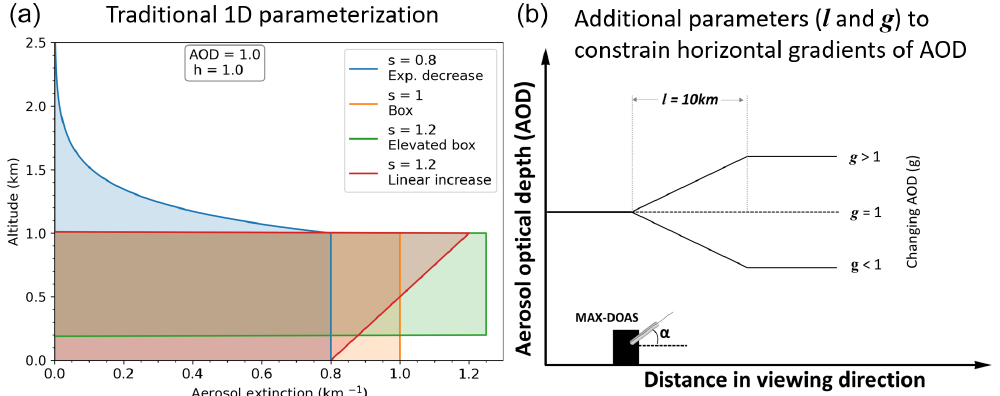
Figure 2. (a) Schematic illustration of traditional 1D parameterized profile inversion which constrains AOD, height ( h ) and shape ( s ) of the profile. The example shown here corresponds to a scenario with AOD = 1 . 0, h = 1 . 0 and four different profile shapes representing exponential decrease, box profile, elevated box profile and linearly increasing profiles. (b) Additional parameters l and g further constrain the horizontal gradients of AOD for 2D profile inversion. Here, g denotes a linear change in AOD for a distance l along the viewing direction of the MAX-DOAS